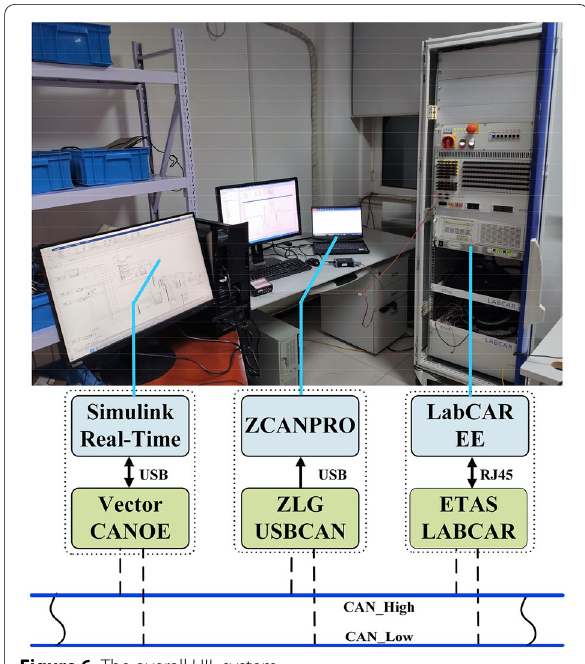
Figure 6 The overall HIL system